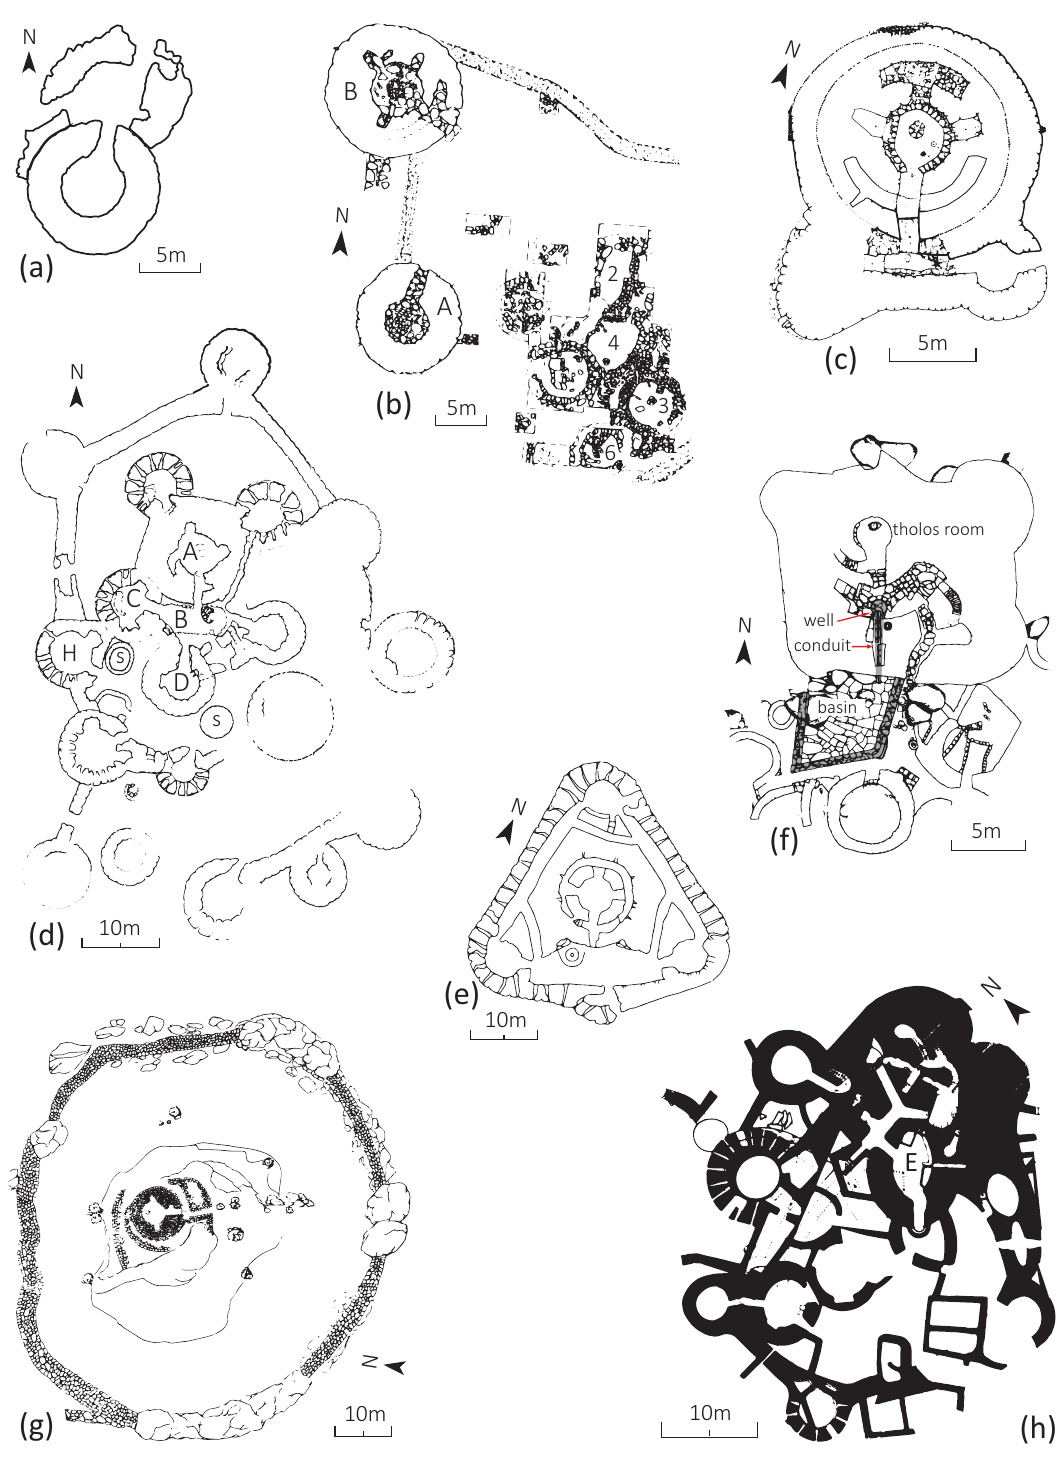
Figure 2: Simpli fi ed plans of selected nuraghi. ( a ) Bingia ’ e Monti, ( b ) Duos Nuraghes, ( c ) Funtana, ( d ) Arrubiu, ( e ) Santu Antine, ( f ) Nurdole, ( g ) Mulinu di Cabu Abbas, and ( h ) Su Mulinu. ( Adapted from Fadda, 1990; Galli, 1989; Lilliu, 1982; Lo Schiavo